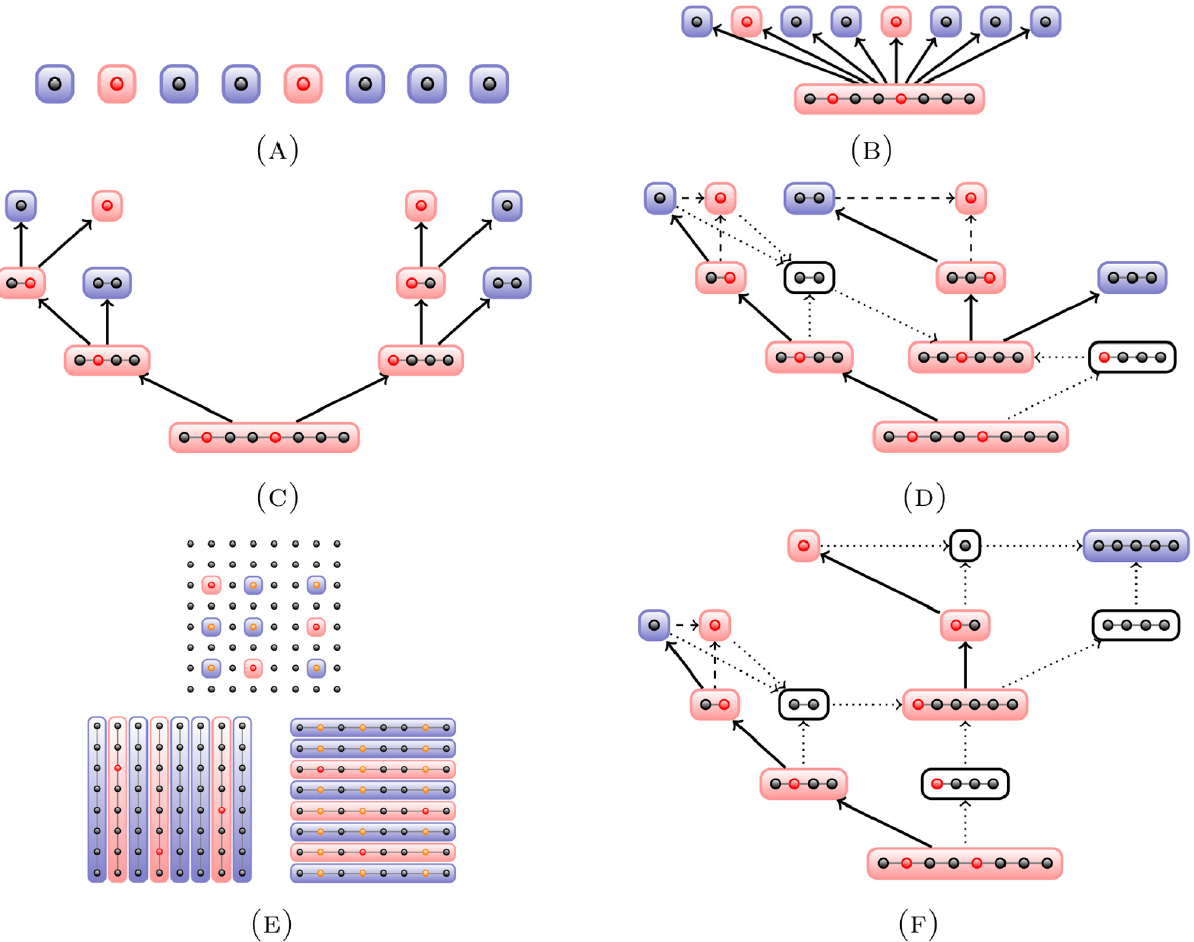
Fig 1. An illustration of finding cases in a pool. Demonstrated for a pool of eight samples for individual testing (A), 2-level pooling (B), binary splitting (C), and Sobel-R1 (F). For recursive binary splitting (D), we show part of the search tree highlighting the difference to binary splitting. For Purim (E), we show the search for three cases in an overall set of 8 2 = 64, starting from 16 pools of size eight (i.e. 8 horizontal and 8 vertical in a matrix arrangement) before testing the